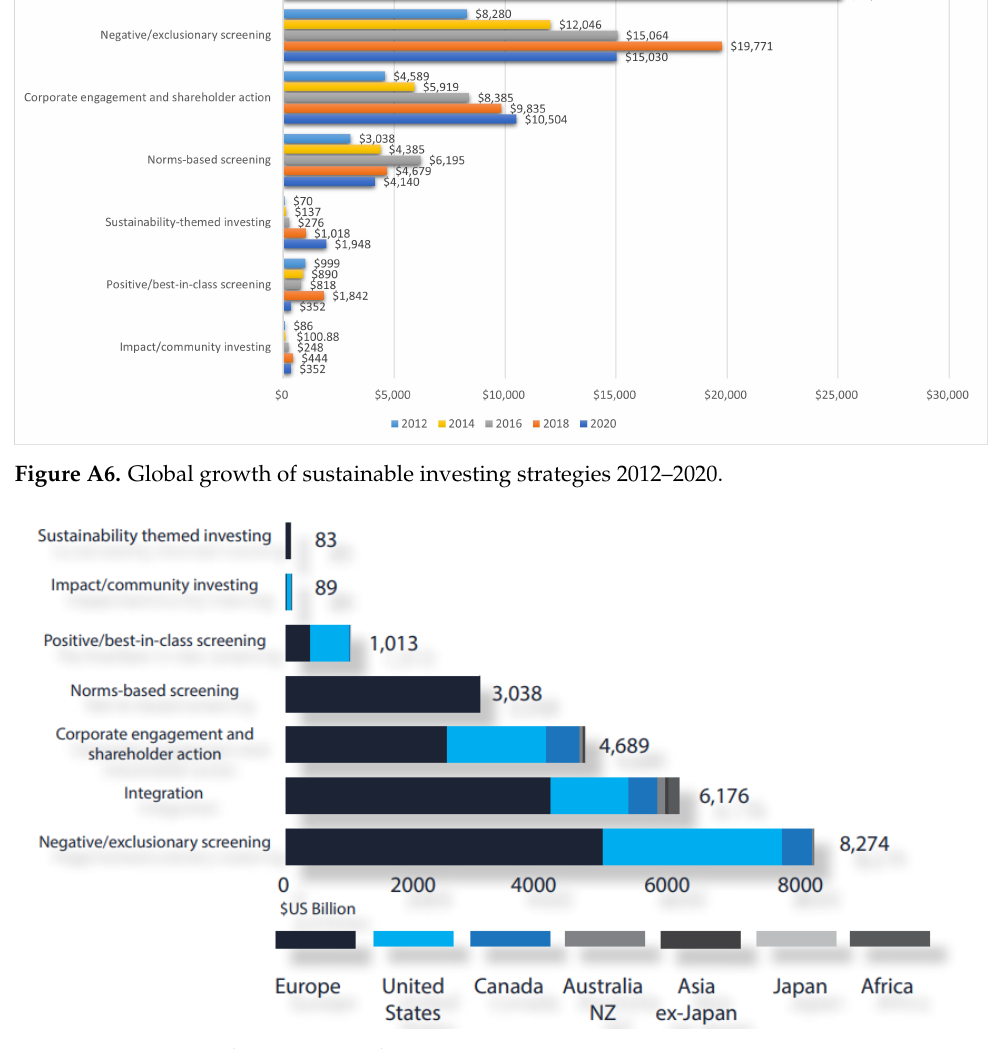
Figure A7. SRI assets by strategy and region 2012.